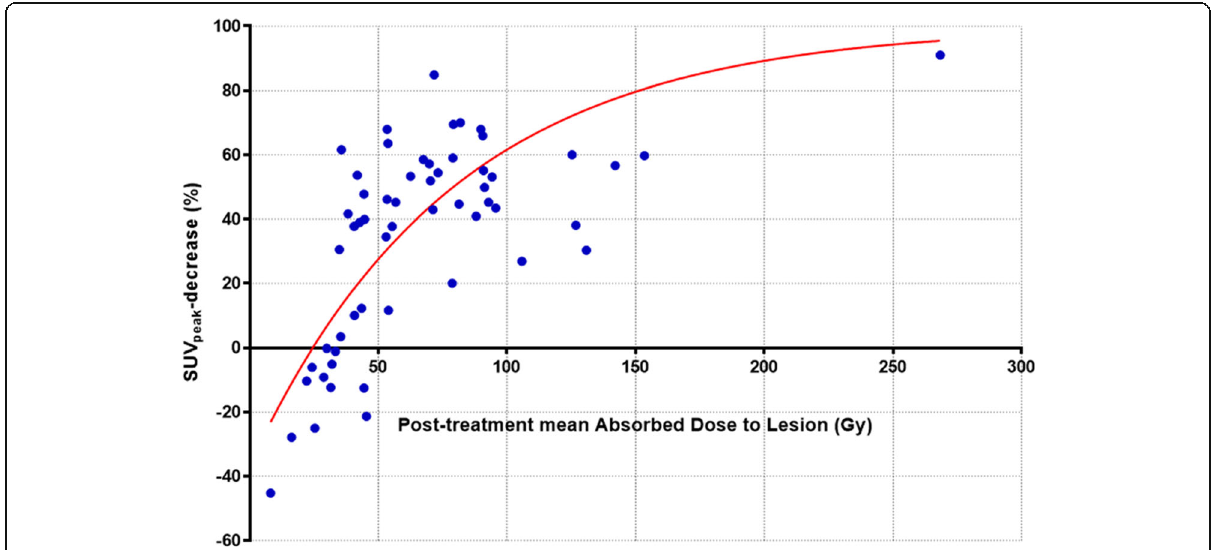
Fig. 2 Regression analysis between post-treatment mean absorbed dose and the metabolic response assessed by SUV peak -decrease on a lesion by lesion basis ( R 2 = 0.52)